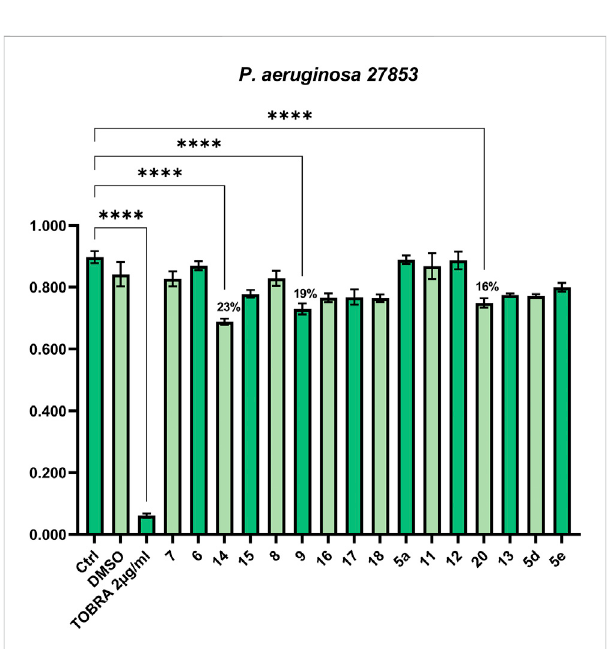
FIGURE 2 Antibacterial effect against Gram-negative P. aeruginosa